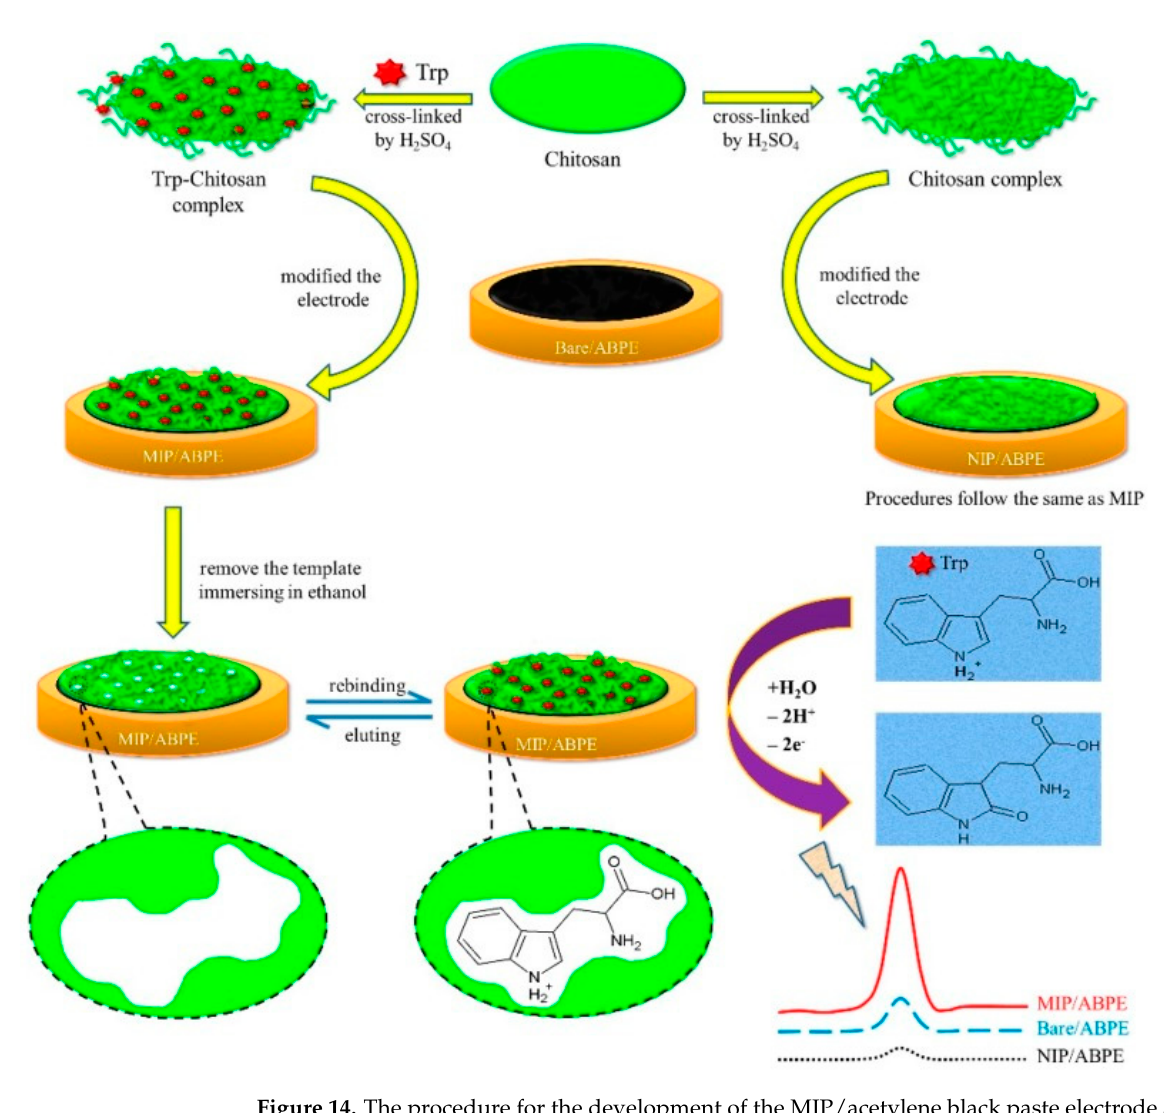
Figure 14. The procedure for the development of the MIP/acetylene black paste electrode and the principle of Trypt detection [159] .